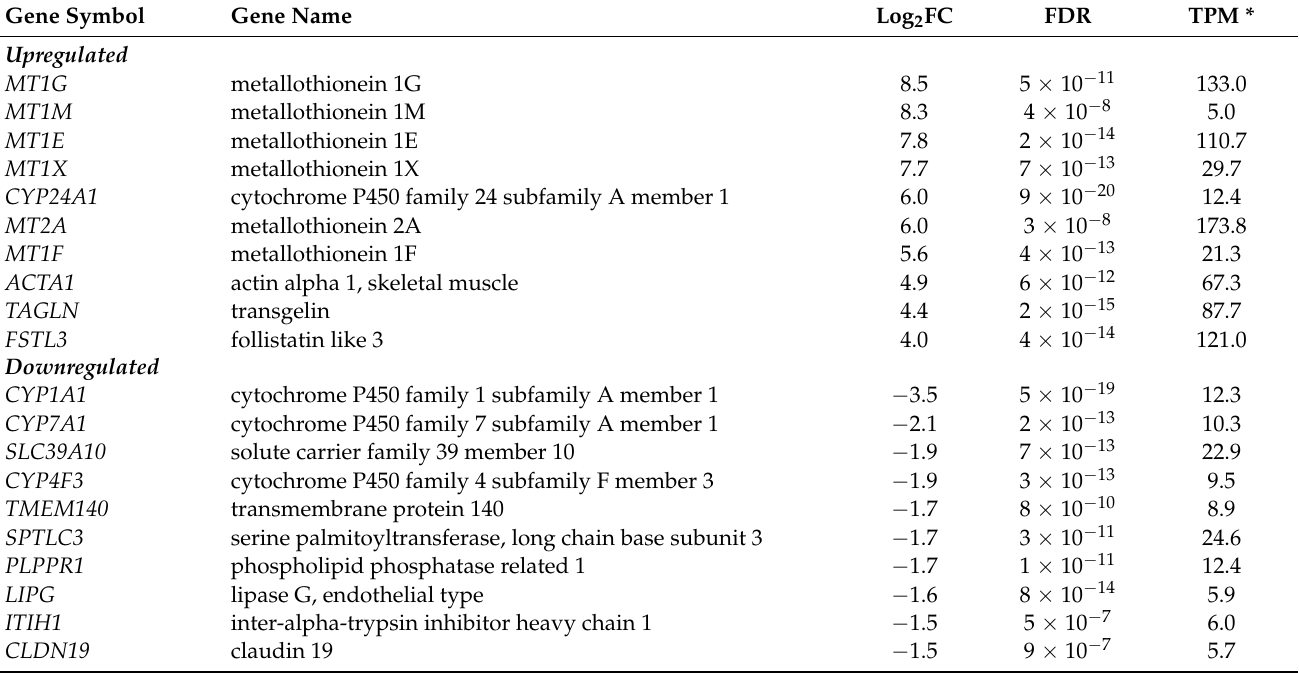
Table S2B,C. Pathway analyses of the genes regulated up or down in cells incubated with fasting serum, compared to cells cultured in serum-free conditions (FC > 1.5, fdr < 0.05), showed PI3K-Akt signalling, Focal adhesion, and Regulation of the actin cytoskeleton